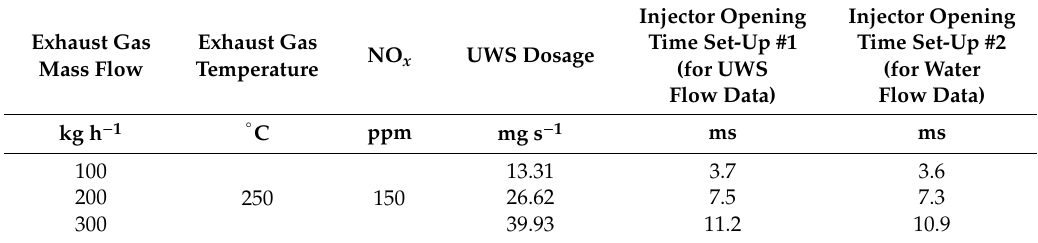
Table 6. Boundary conditions for computational fluid dynamics (CFD)